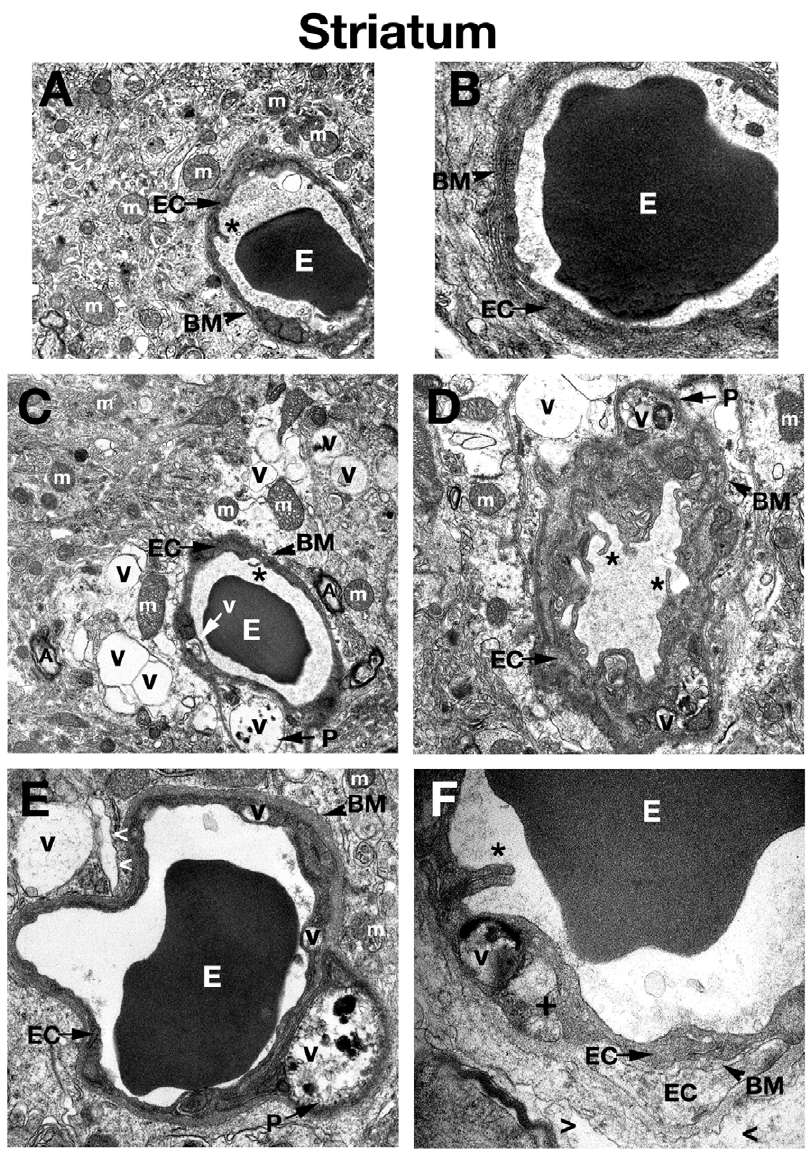
Figure 3. Electron microscope examination of the striatum of Naglu mutant mice. ( A ) Structural integrity of capillaries in the striatum was normal in C57 BL/6J control mice. ( B ) A single layer of endothelial cells surrounded by a layer of basement membrane in control mouse seen at high magnification. ( C ), ( D ) Edematous space and large vacuoles are indicated around vessels. Vacuolated pericytes can be seen in the striatum of early symptomatic Naglu mice. ( E ) Large vacuoles were found in endothelial cells and pericytes of late symptomatic animals. ( F ) A high magnification image of a capillary from the striatum of a 6 month old mutant mouse showing an endothelial cell with endoplasmic reticulum swelling and formation of a large vacuole in its cytoplasm. Edematous space has appeared around the capillary. Multiple layers of endothelial cells and basement membrane can be observed here, indicating a reparative process taking place. The luminal endothelial cells are damaged . EC - endothelial cell, BM - basement membrane, E – erythrocyte, m – mitochondrion, A – axon, P – pericyte, PM – perivascular macrophage, Nu – nucleus, V – vacuole, + - swollen endoplasmic reticulum, asterisks - microvilli, . - extracellular edematous space. Magnifications: ( A ), ( C ): 7,100x; ( B ), ( E ): 14,000x; ( D ): 8,900x; ( F ): 28,000x.